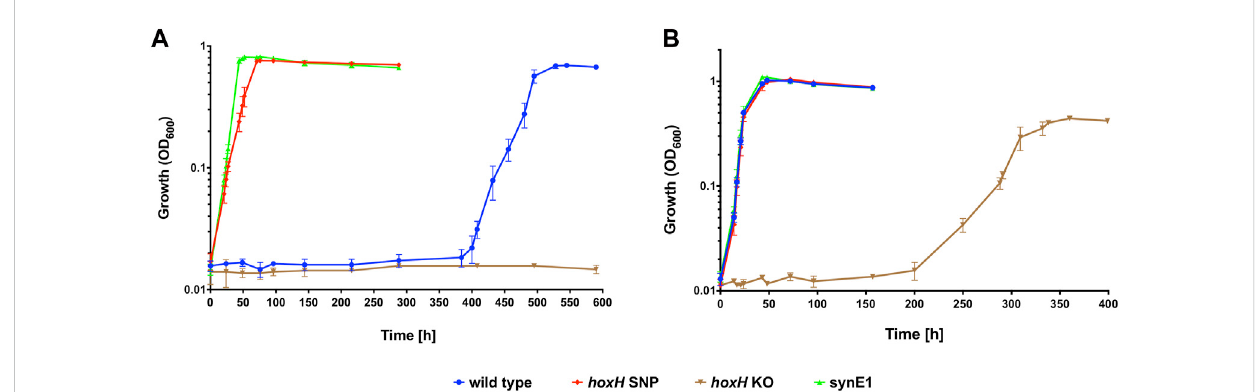
FIGURE 8 Autotrophic(A)andheterotrophicgrowth(B)of C.necatorhoxH SNP, hoxH KOandsynE1strainscomparedtotheH16wildtypeunderasyngas-like atmosphere. Cultures were grown at 30 ° C in 25 mL MM contained in 250 mL serum bottles under a 2.4 bar atm of (A) 15% CO/65% H 2 /10% CO 2 /10% air (v/v) or (B) 15% CO/65% H 2 /10% CO 2 /10% air (v/v). Blue circles, wild type; red squares, hoxH SNP; inverted brown triangles, hoxH KO; green triangles, synE1. Error bars represent the standard deviation of the mean for three independent